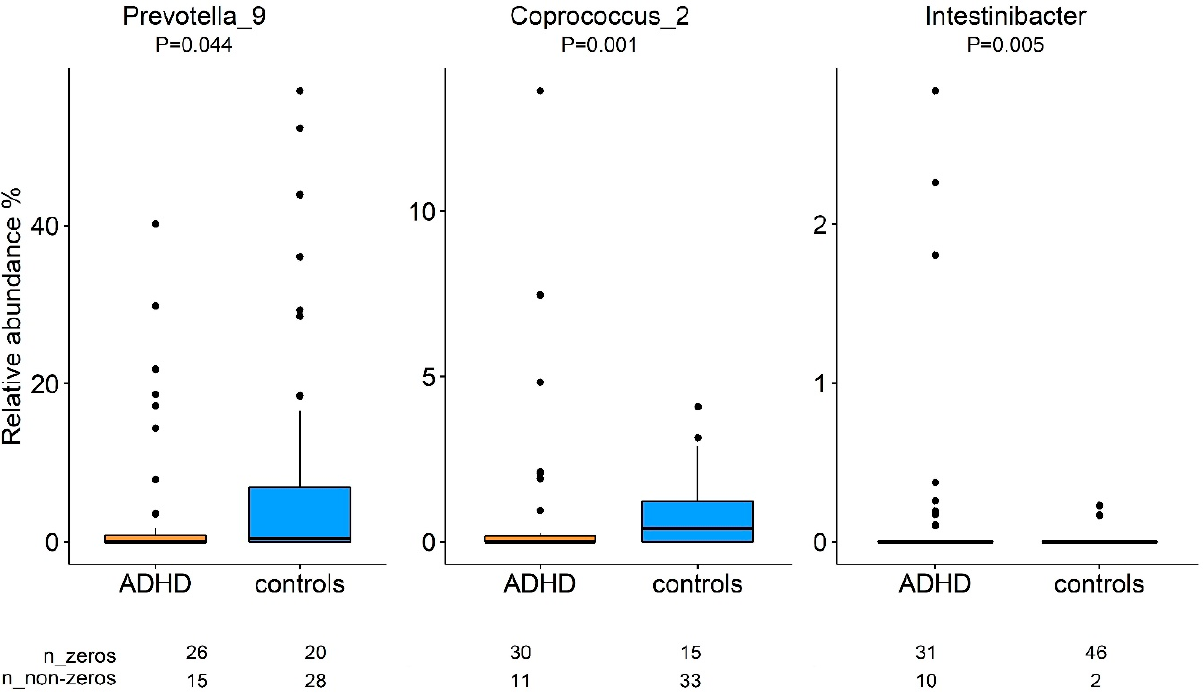
Figure 2. Comparison of bacterial relative abundance between participants with ADHD and controls. Identification of the bacteria differences was made by the Mann-Whitney test. No outliers were removed since we used a non-parametric test which is less sensitive to the extreme values. Box plots represent median with whiskers on ± 1.5 IQR. Nominal significant threshold: p < 0.05. Table 3. Association of the genera with ADHD symptoms scores.